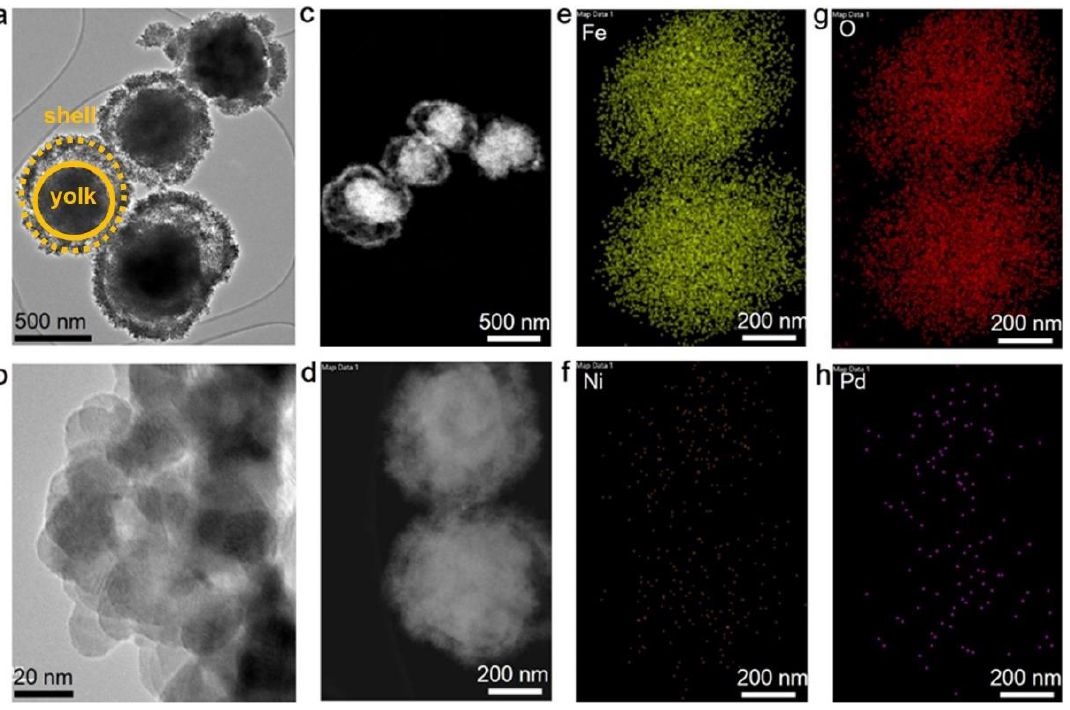
Figure 3. ( a , b ) TEM images, ( c , d ) HADDF-STEM images, and ( e – h ) corresponding EDX elemental mapping of Ni-Pd/Fe 3 O 4 yolk-shelled nanospheres.